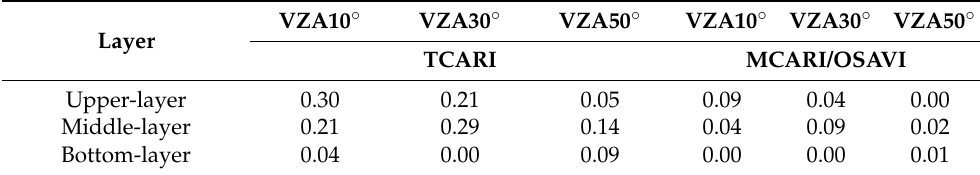
Table 6. Coefficient of determination (R 2 ) of the leaf chlorophyll content obtained from the vegetation indices at different VZAs in the upper-, middle-, and